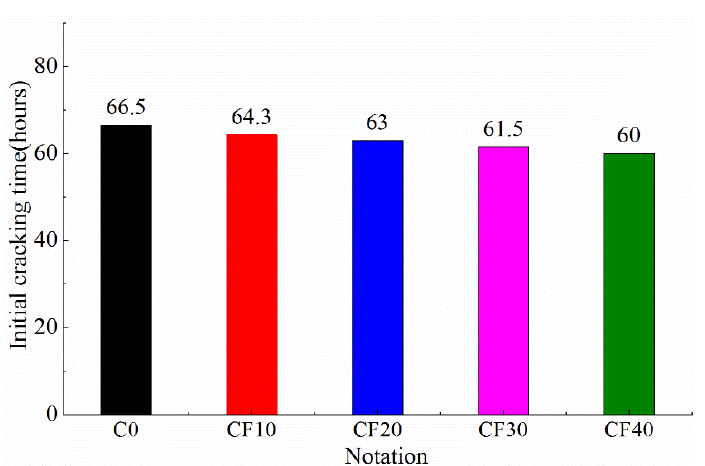
Figure 6. The restrained ring test results of face slab concretes with various fly ash dosages.